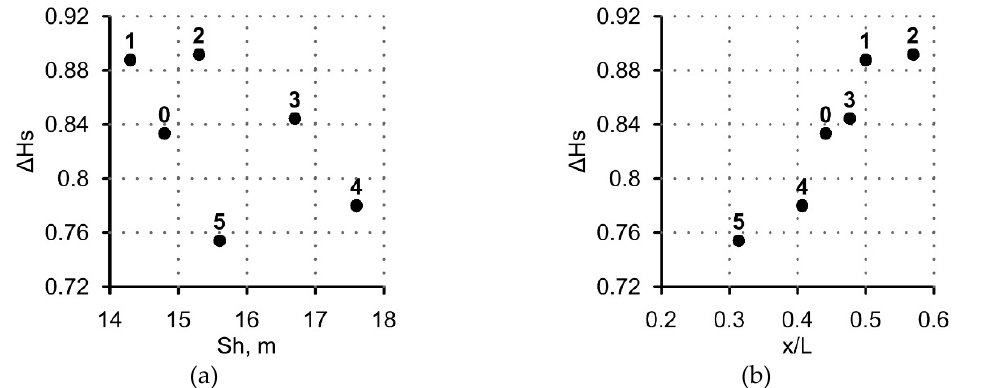
Figure 7. Dependence of ( a ) the shoreline retreat (Sh, m) and ( b ) the relative distance of seaward sediment transport (x/L) on the relative change in significant wave height ( Δ Hs, m) occurring during wave transformation over barred profile (620–820 m, see Figure 4). L is wave length calculated for deep water conditions, x is distance of maximal sediments transport away from the shore The shoreline retreat is influenced more by the mean wave period than by wave height. Figure 8